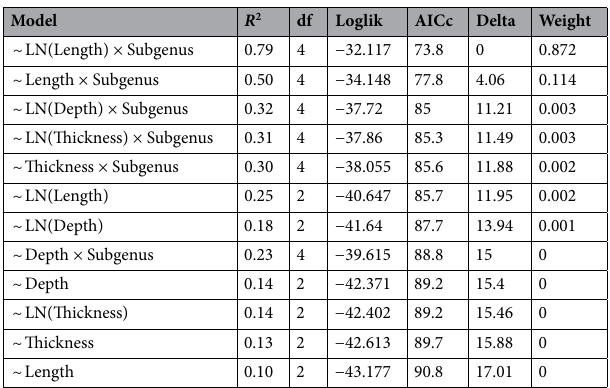
Table 1. Model selection table for flammability of 31 North American Pinus species. Models were fit using the first principal component of flammability (PC1) as the dependent variable. Subgenus was either Pinus or Strobus . LN natural log, length needle length, thickness needle thickness, depth litter depth.